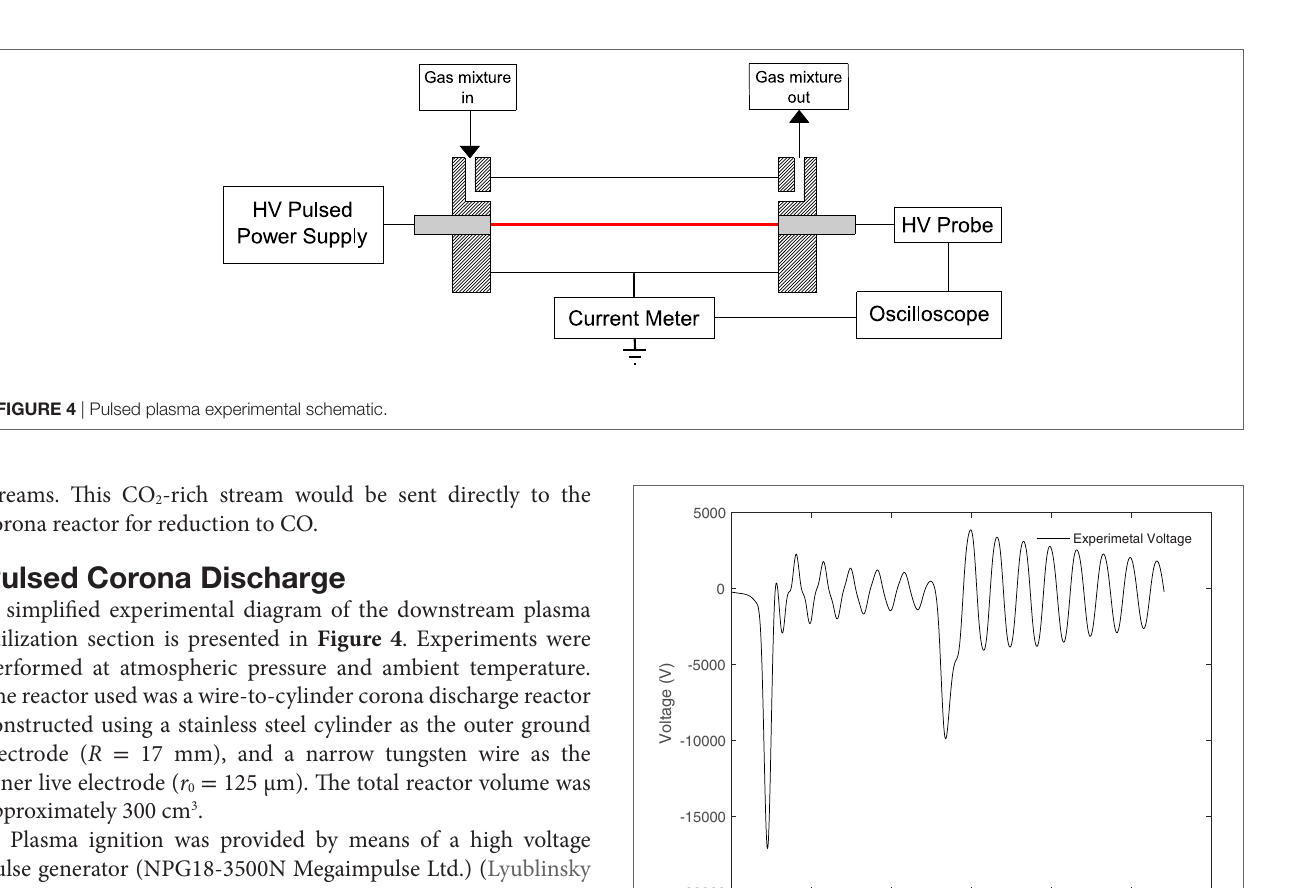
FigUre 3 | Cross-sectional view of the packed-bed adsorber used for CO 2 separation from simulated flue gas